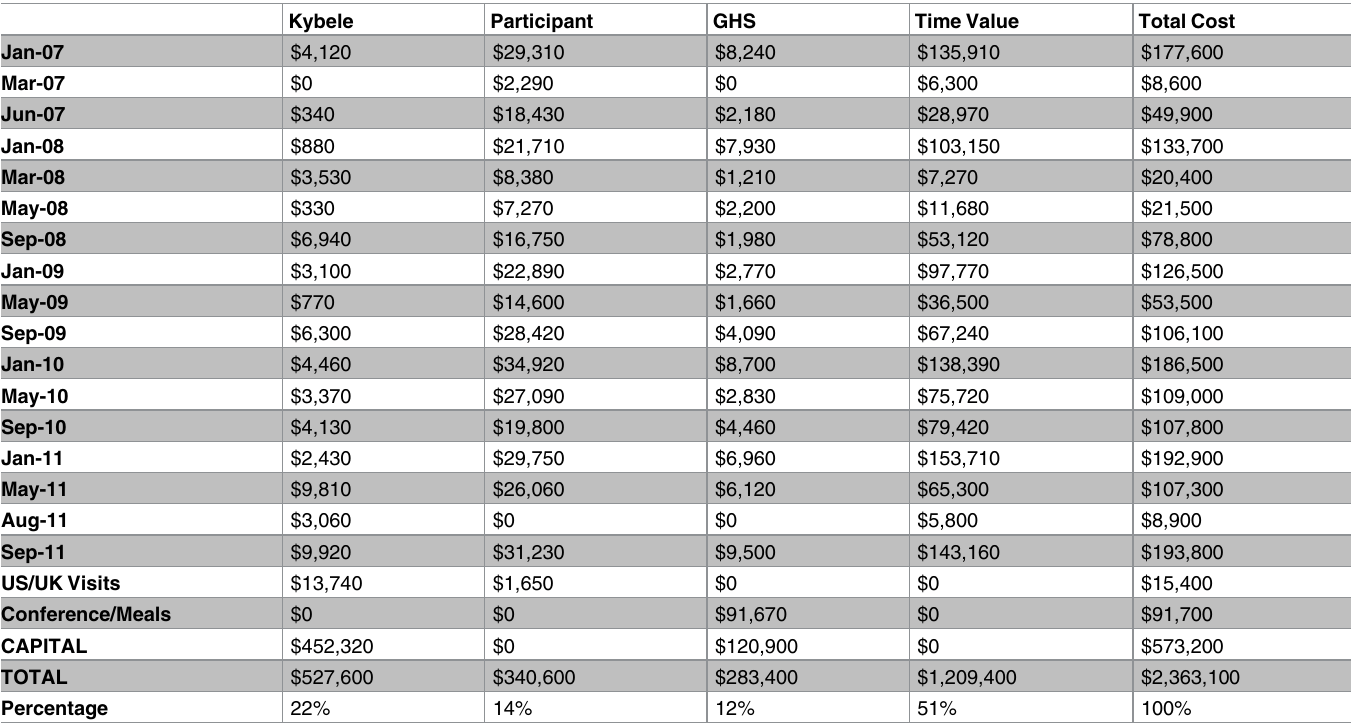
Table 1. Kybele-GHS partnership